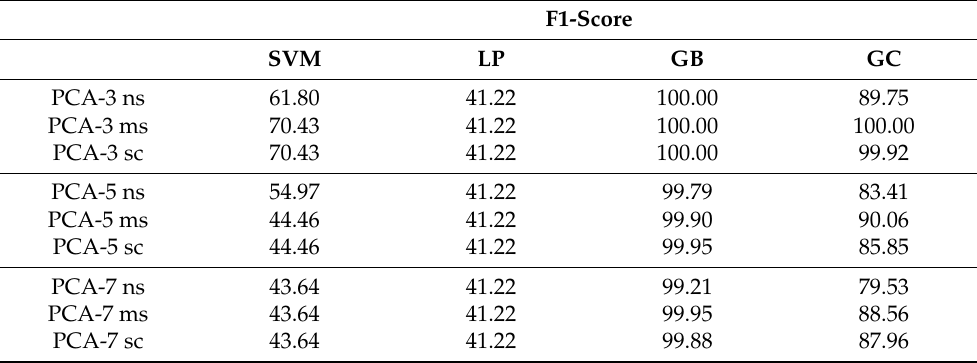
Table 2. The F1 score for classification of HSI2 image 1 using PCA 3, 5, and 7 bands and the different scaling and normalization methods using the four machines.